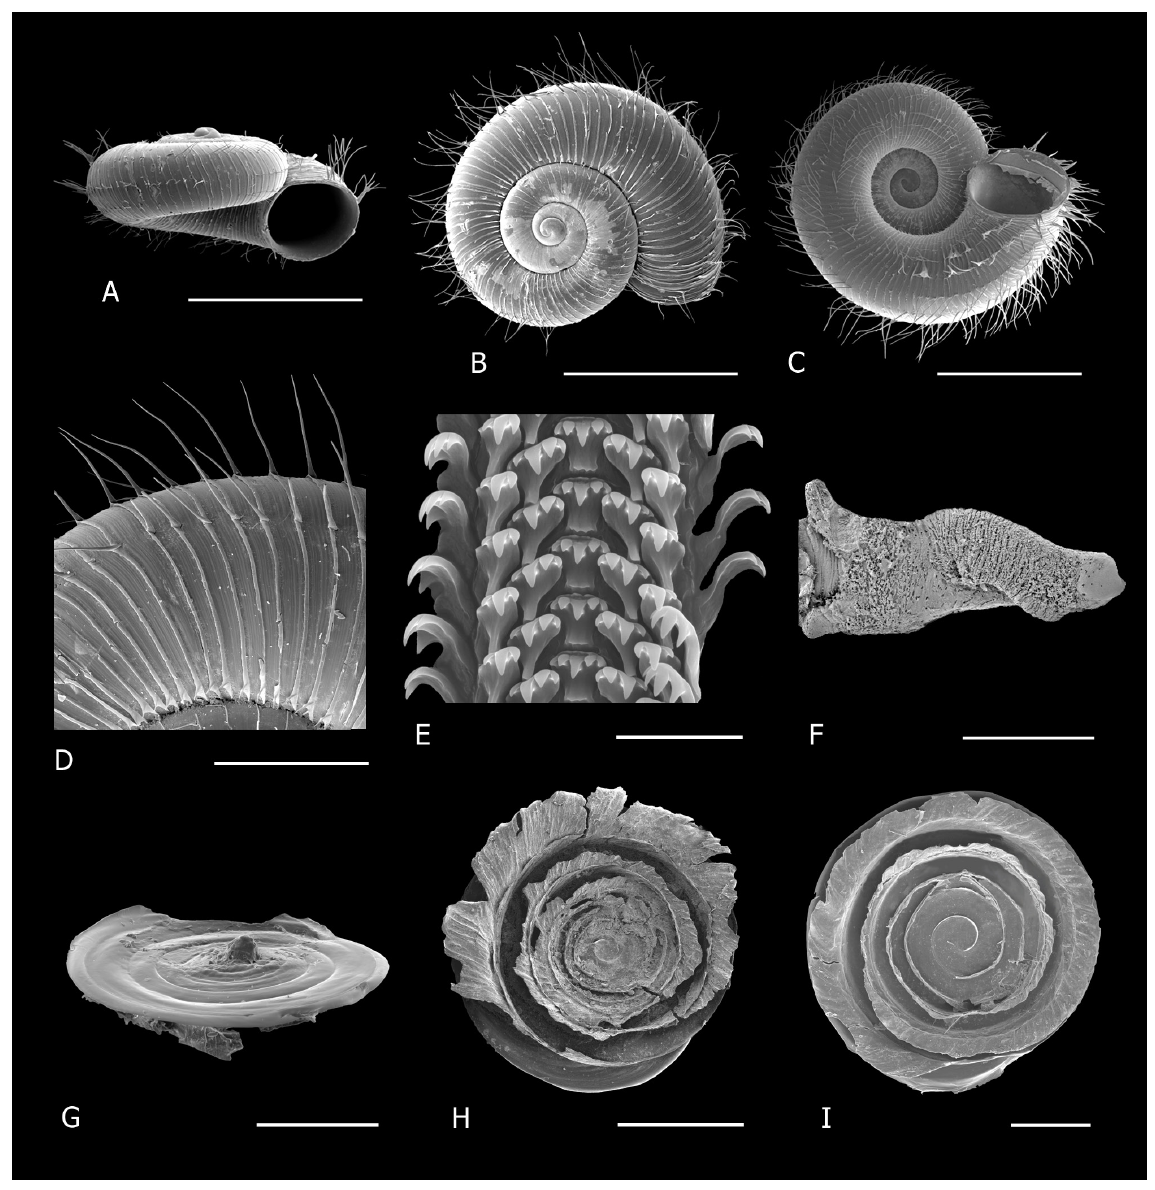
Fig. 27. Afrocyclus isipingoensis (Sturany, 1898) gen. et comb. nov. A . Aperture view (ELM W3648). B . Dorsal view (ELM W3648). C . Ventral view (ELM W3648). D . Detail of axial lamellae of periostracum (ELM D16897). E . Portion of radula (ELM W3650). F . Penis, dorsal view, showing position behind right tentacle (ELM W3652). G . Operculum, inner portion, showing tubercle (ELM W3648). H .